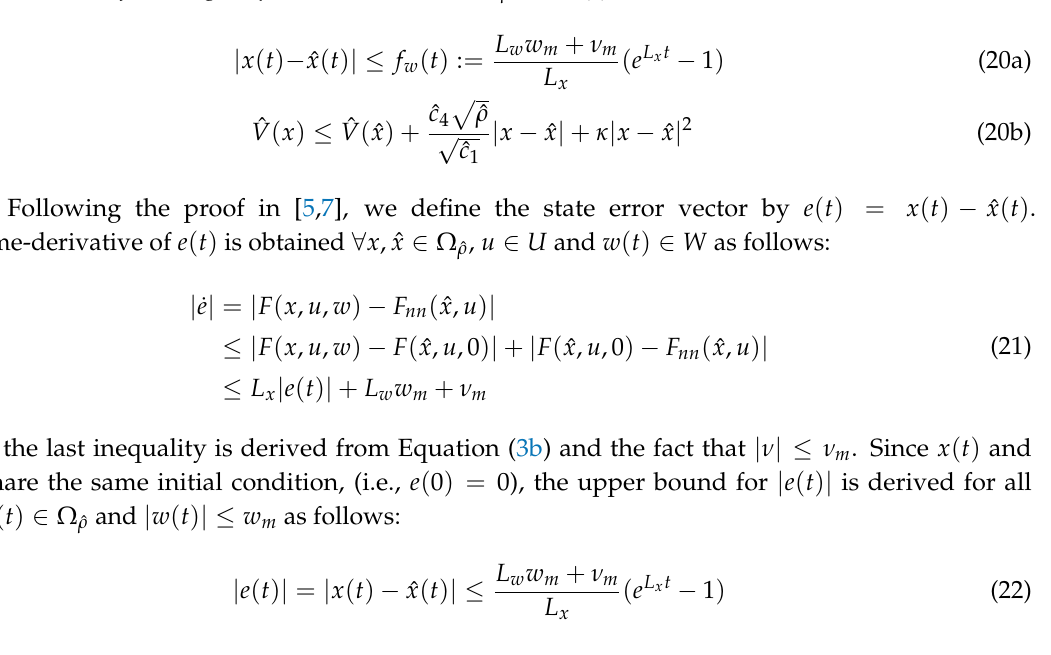
Figure 4. A schematic representing the set ˆ φ u , the closed-loop stability region Ω ˆ ρ , and the set Ω ˆ ρ Under the LEMPC of Equation (19), the closed-loop state trajectory is bounded in Ω ˆ ρ for all times for any x 0 ∈ Ω ˆ ρ